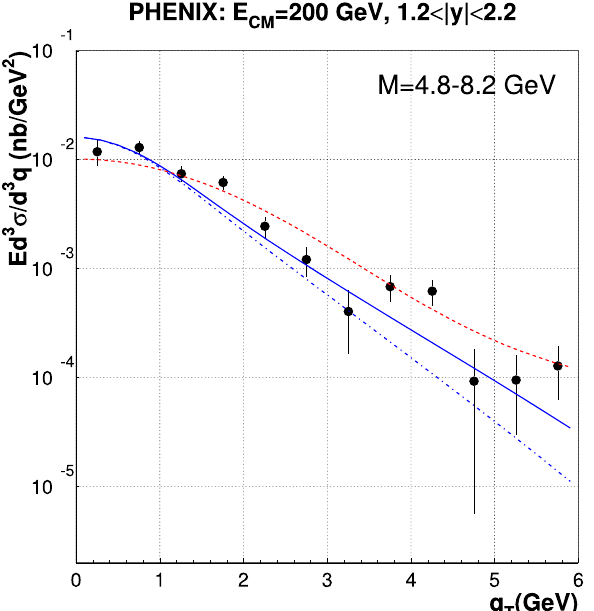
Fig. 9 Transverse momentum dependence of DY cross-section in proton–proton collisions: data from PHENIX [46] compared with on- shell CCFM-K (blue solid), off-shell CCFM-K (blue dash-dotted) and CSS (red dashed)